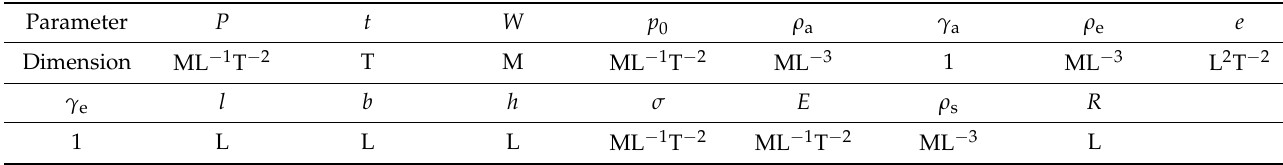
Table 1. Parameters and dimensions for internal